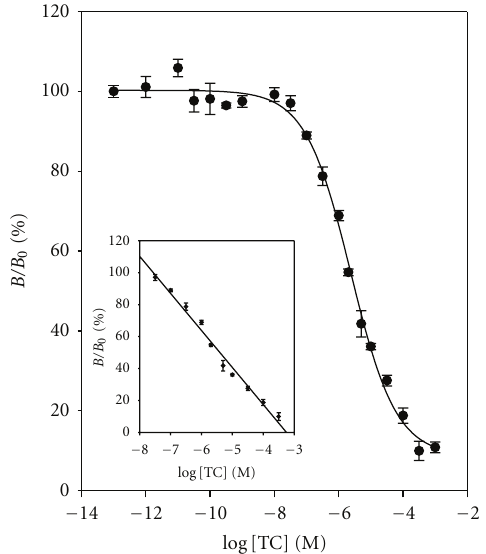
Figure 8: Dose-response curve and calibration curve (inset) for TC in bu ff er. % B/B 0 = − 23 . 1788 × log [TC] − 75 . 2471, R 2 = 0 . 9851. Data points are the average plus ± one standard deviation ( n = 3).